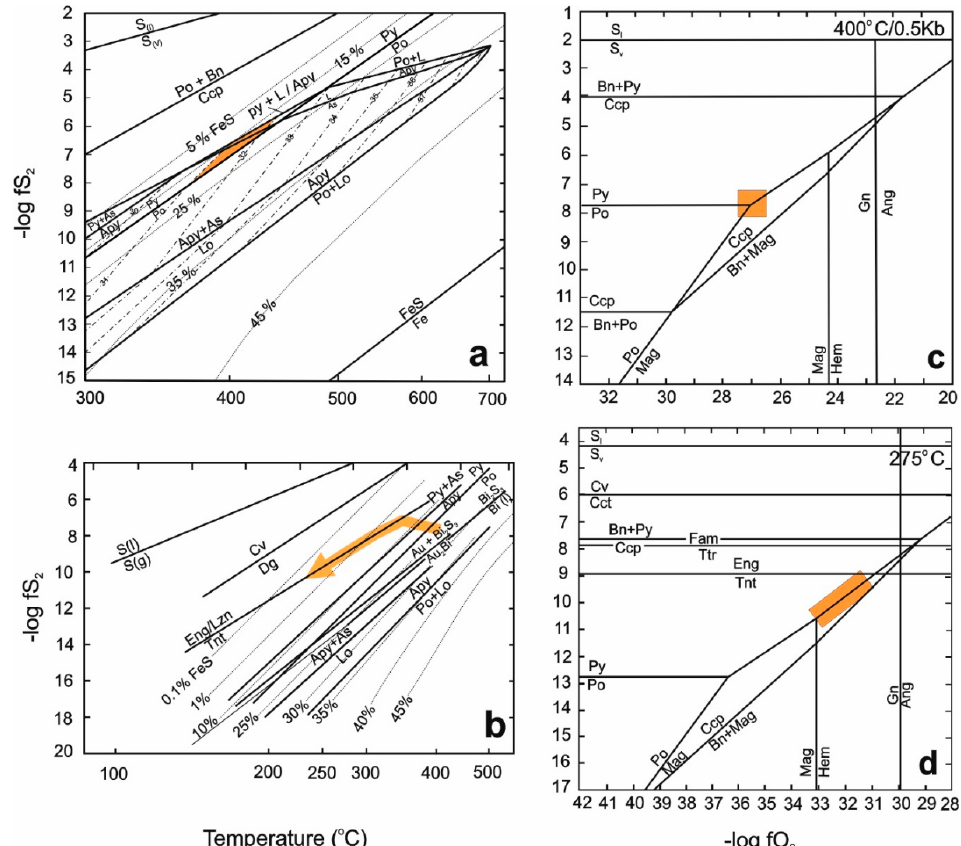
Figure 8. ( a , b ) Log f S 2 -T diagrams showing sulfidation reactions and hypothetical conditions of formation of the Clemence Ni-Au-Bi mineralization. The mineral stability field in the Fe–As–S system, as well as the isopleth contours of As in arsenopyrite (at. %; dash-dotted lines) in equilibrium with vapor, were derived from Kretschmar and Scott [48] and Sharp et al. [49]. The iron content in sphalerite (moles % FeS; dotted lines) is drawn according to the data of Scott and Barnes [50]. Stability fields of native bismuth/bismuthinite and native gold + bismuthinite/maldonite and other sulfidation reactions involving sulfides, sulfarsenides, sulfosalts and native elements were derived from Barton and Skinner [51]. The conditions of formation during the precipitation of arsenopyrite and pyrite are indicated by the shaded area in Figure 5c. An evolution towards higher sulfur fugacities and then along the enargite/tennantite boundary with decreasing temperatures is indicated by the arrow in Figure 5b. ( c , d ) Log f S 2 –log f O 2 diagrams indicating equilibria among sulfides, oxides, and silicates at ( c ) 400 °C/0.5 kb and ( d ) 275 °C and vapor saturation for the prograde and retrograde skarn assemblages at Kamariza. The shaded area indicates approximate conditions of skarn formation. Abbreviations: Apy = arsenopyrite, Bn = bornite, Ccp = chalcopyrite, Cct = chalcocite, Cv = covellite, Eng = enargite, Fam = famatinite, Hem = hematite, L = liquid, Lol = löllingite, Mag = magnetite, Po = pyrrhotite, Py = pyrite, Tnt = tennantite, Ttr = tetrahedrite, Sl = sulfur liquid, Sv = sulfur vapor.